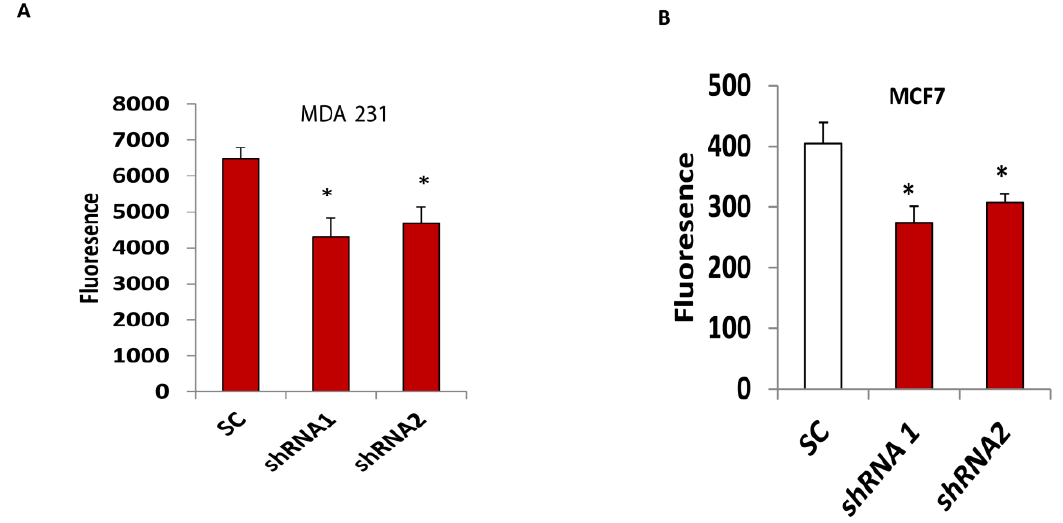
Figure 5. Silencing CLDN1 inhibits breast cancer cell invasion. ( A , B ) Invasion of two CLDN1 lentiviral shRNA transduced MDA-MB-231 ( A ) and MCF7 ( B ) cells were compared